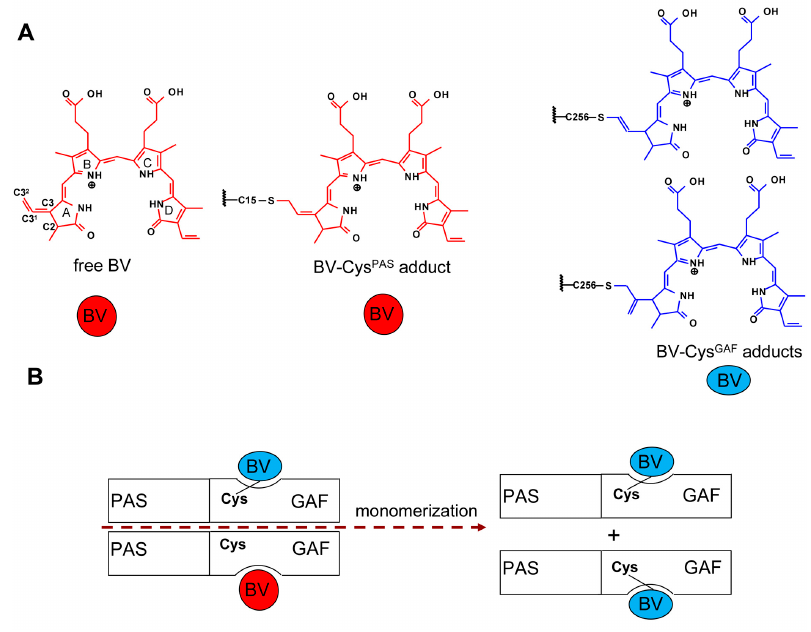
Figure 6. Scheme of the inter-monomeric effects in dimeric and monomeric NIR FPs. ( A ) Chemical structures of BV chromophores; ( B ) In dimeric NIR FPs inter-monomeric allosteric influence on the BV interaction with the protein results in covalent binding of BV only with one monomer of dimmer (the case of NIR FPs with Cys GAF only is shown). Monomeric BphP1-FP variants contained only covalently bound